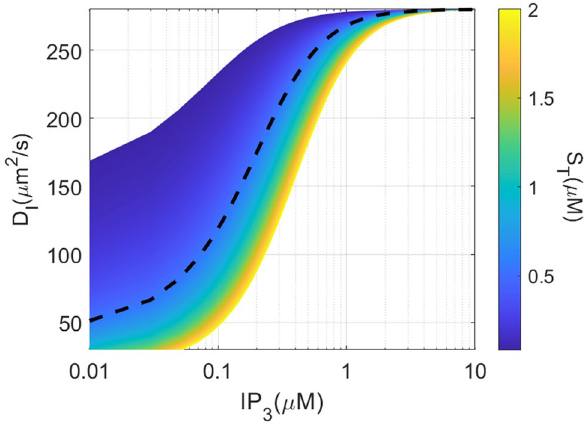
Figure 1. Theoretical values of the effective IP 3 diffusion coefficient depending on the concentration of IP 3 and of the monomers of IP 3 receptors (S T ). The dashed line shows this diffusion coefficient as a function of [IP 3 ] for S T = 542 nM, which is the value estimated for SH-S5Y5 neuroblastoma cells. Values have been calculated using Eq. 1. See text for